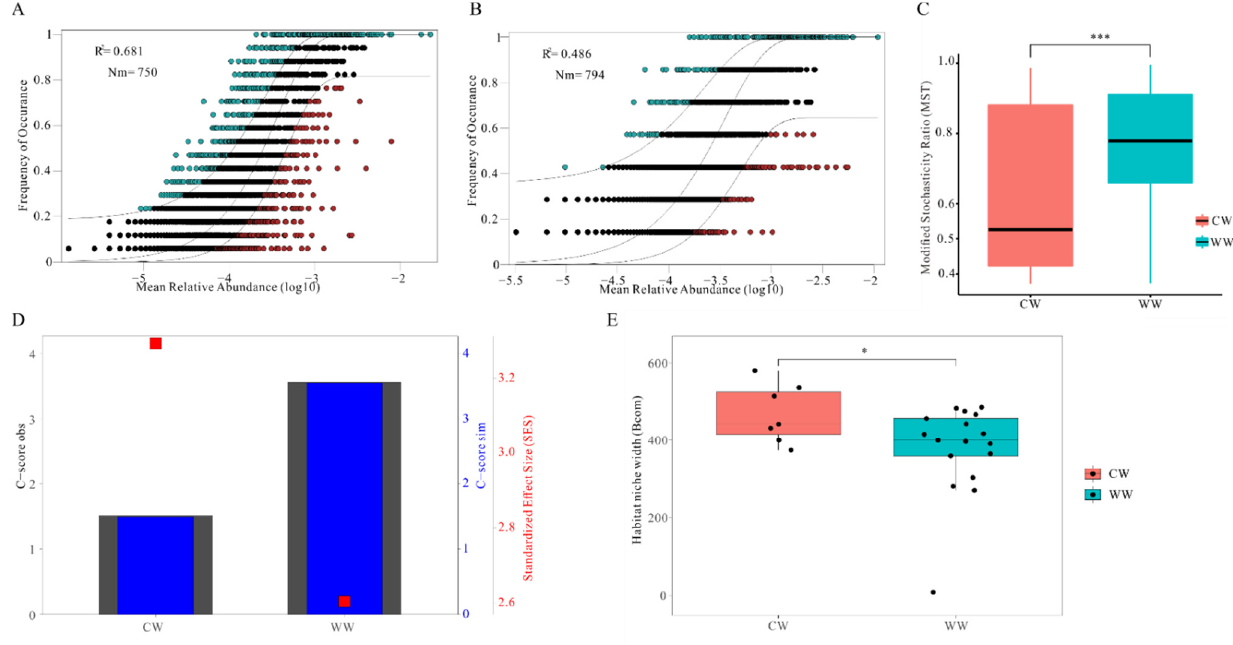
Figure 4. Ecological processes shaping gut microbiota communities in CW and WW white-lipped deer. ( A , B ) Predicted occurrence frequencies for WW and CW represent gut microbiota communities from WW groups. Solid blue line indicates best fit to neutral community model (NCM), dashed blue line indicates 95% confidence intervals around NCM prediction. OTUs that occur more or less frequently than predicted by NCM are shown in green and red, respectively. R 2 represents fit to this model. ( C ) Evaluation of the relative significance of determinate and stochastic process between CW and WW. If modified stochasticity ratio (MST) >0.5, deterministic processes dominate; if MST < 0.05 stochastic process dominate (Not significant, p > 0.05; * 0.01 < p < 0.05; *** p < 0.01). ( D ) C-score index using null models. Values of observed C-score ((C-score obs) = simulated C-score (C-score sim)) indicate random co-occurrence patterns. Standardized effect sizes -2 and > 2 represent aggregation and segregation, respectively. ( E ) Comparison of mean habitat niche breadth for CW and WW groups (Not significant, p > 0.05; * 0.01 < p < 0.05; *** p < 0.01).